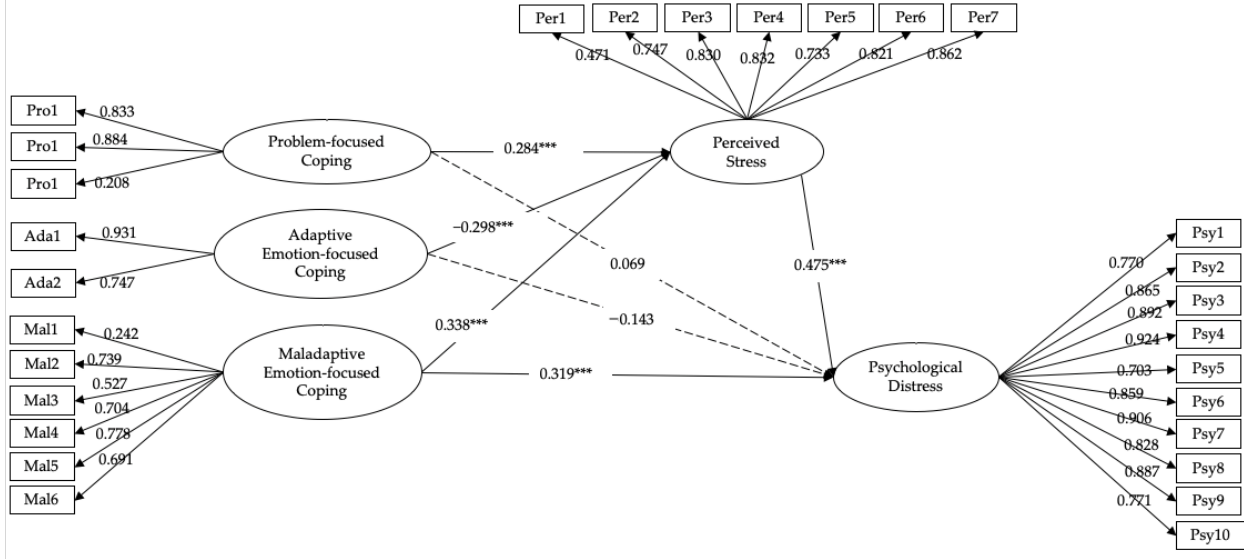
Figure 1. Mediation model of the association between different coping styles and psychological distress. Note: all the loadings on latent variables were significant ( p < 0.001). *** p < 0.001. Pro = Problem-focused; Ada = Adaptive Emotion- focused Coping; Mal = Maladaptive Emotion-focused Coping; Per = Perceived Stress; Psy = Psychological Distress.